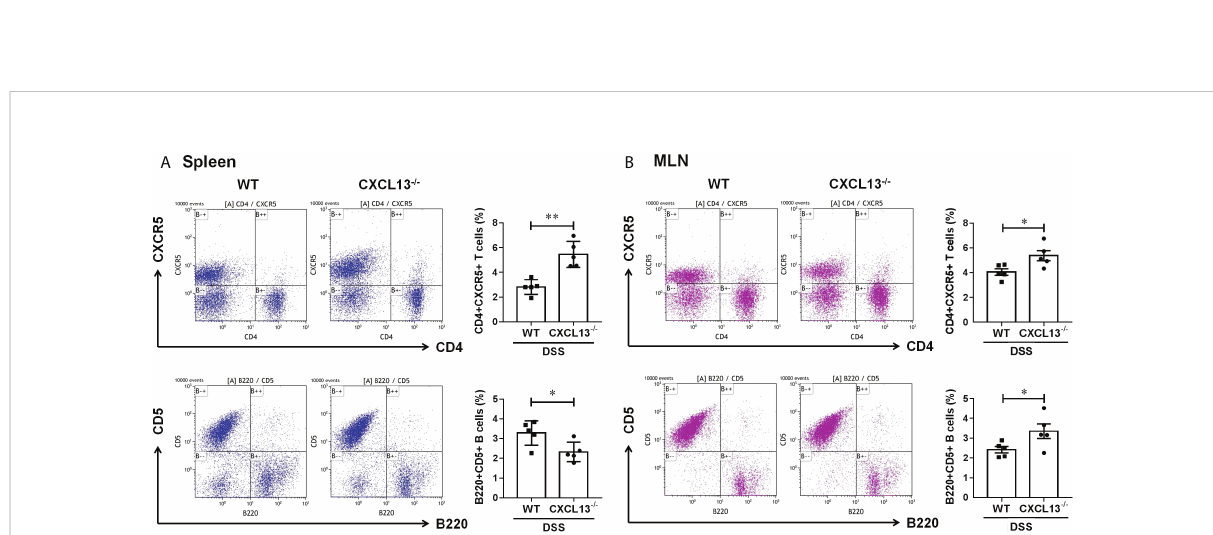
FIGURE 4 CXCL13 regulates the recruitment of CD4+CXCR5+ T cells in colitis mice, thereby promoting the increasing of regulatory B cells in colon. Flow cytometry analysis of CD4+CXCR5+ T cells and B220+CD5+ B cells in (A) spleen and (B) MLN of WT and Cxcl13 -/- mice with colitis. In Cxcl13 -/- knockout mice, CD4+CXCR5+ T cells were signi fi cantly increased in both spleen and MLN, while CD5+ B cells were decreased in spleen and increased in MLN. These data suggest that CXCL13 is involved in inhibiting CD4+CXCR5+ T cell recruitment to secondary lymphoid organs from circulating and MLN. The increase of CD4+CXCR5+ T cells in MLN of Cxcl13 -/- mice promoted the increase of CD5+B cells in local colon tissue. Summary data are presented as mean ± SEM based on multiple mice, with P values determined by two-tailed Student ’ s t test. * P < 0.05; ** P < 0.01.